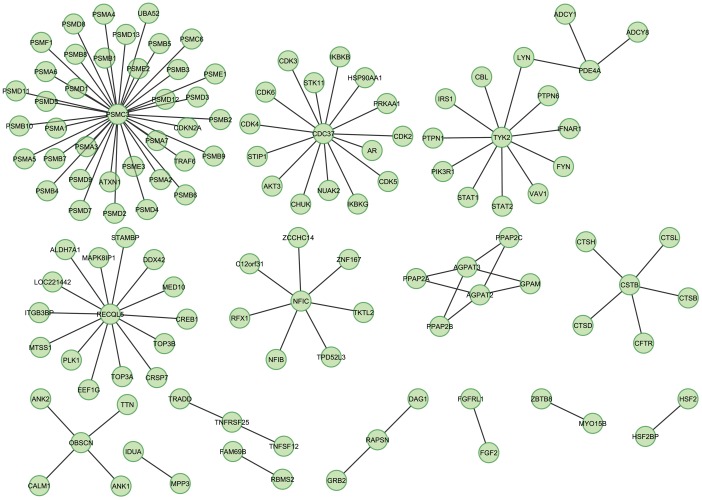
Representative Interactions of the Lifespan Longevity Associated Genes Identified.Gene-gene interactions of independently significant loci. Additional genes implicated by interacting with genes in significantly associated longevity loci. Alternative splicing gene function annotation enrichment of significant loci suggests diverse genetic perturbation with a common biological role. Extension of this functional category to other genes annotated by functional studies with interactions to associated genes implicates potential for screening diverse etiology.